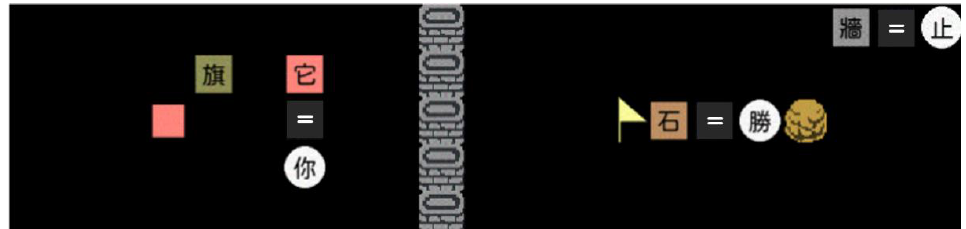
Figure 1. An example of the game field where several objects and word tiles are presented, which determine the layout and the rules of the episode.